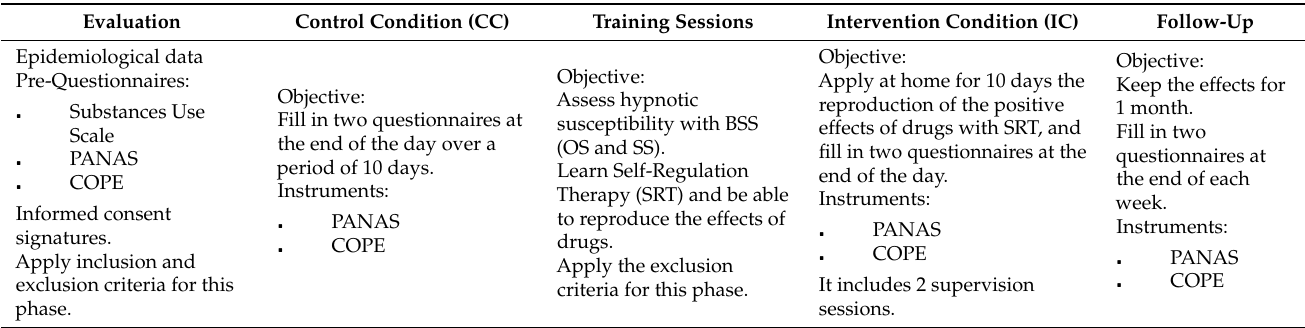
Table 1. Procedure